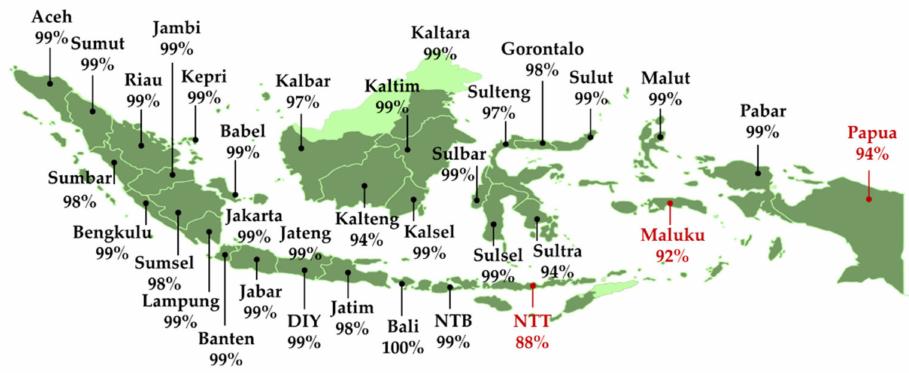
Figure 1. Indonesia provincial electrification ratio in 2020 (data from